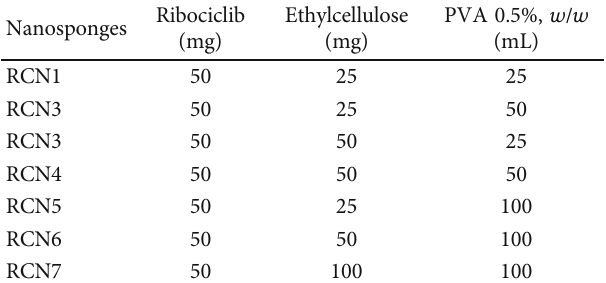
Table 1: Composition of ribociclib-loaded nanosponges.